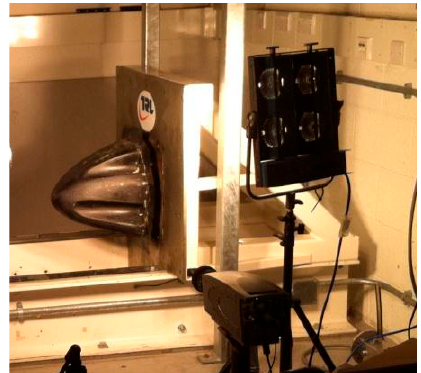
Figure 7. Sled impact tester at TRL [18].